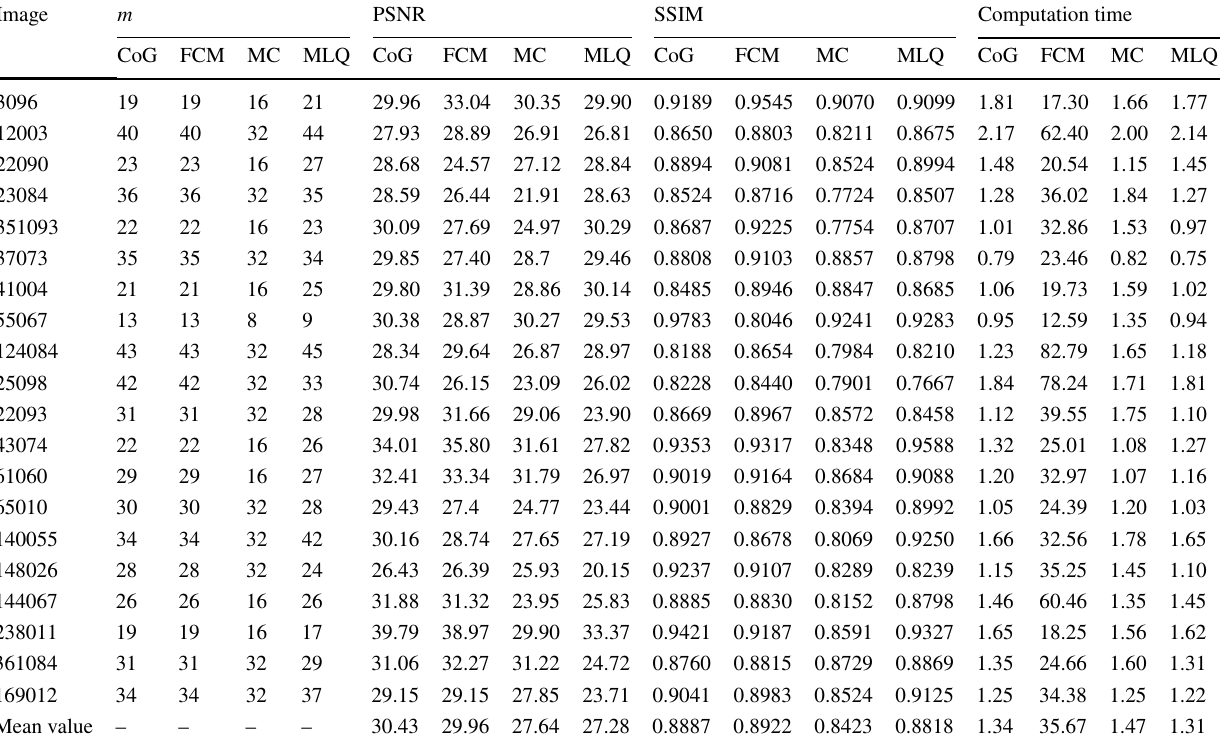
Table 5 Overall performance of algorithms with various metrics for t = 3 Image